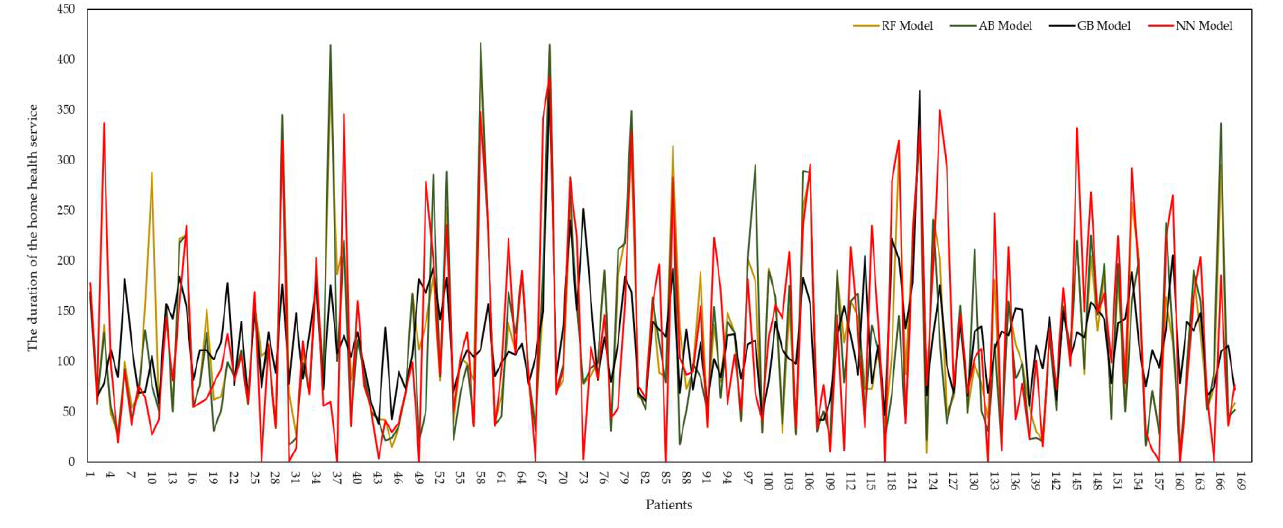
Figure 7. Prediction data of RF, AB, GB, and NN algorithms.